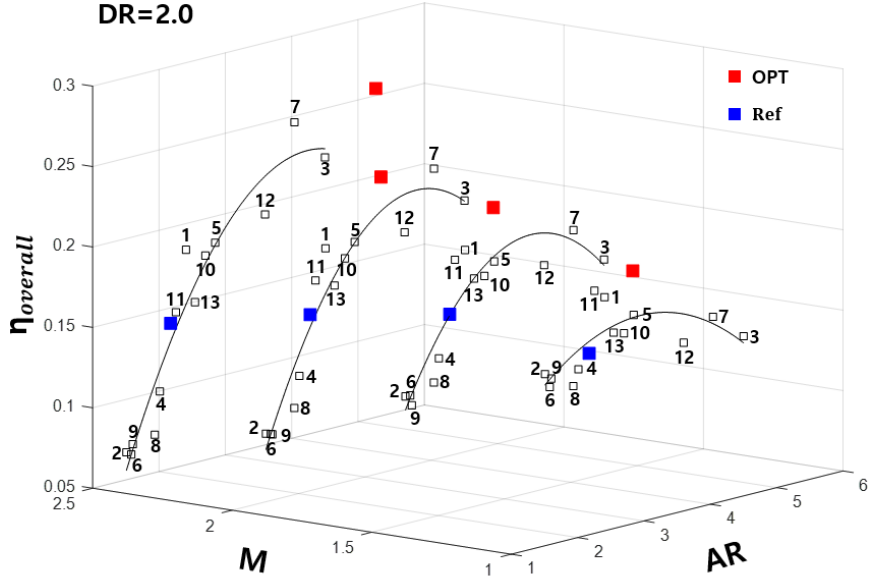
Figure 14. Overall averaged FCE for area ratio.